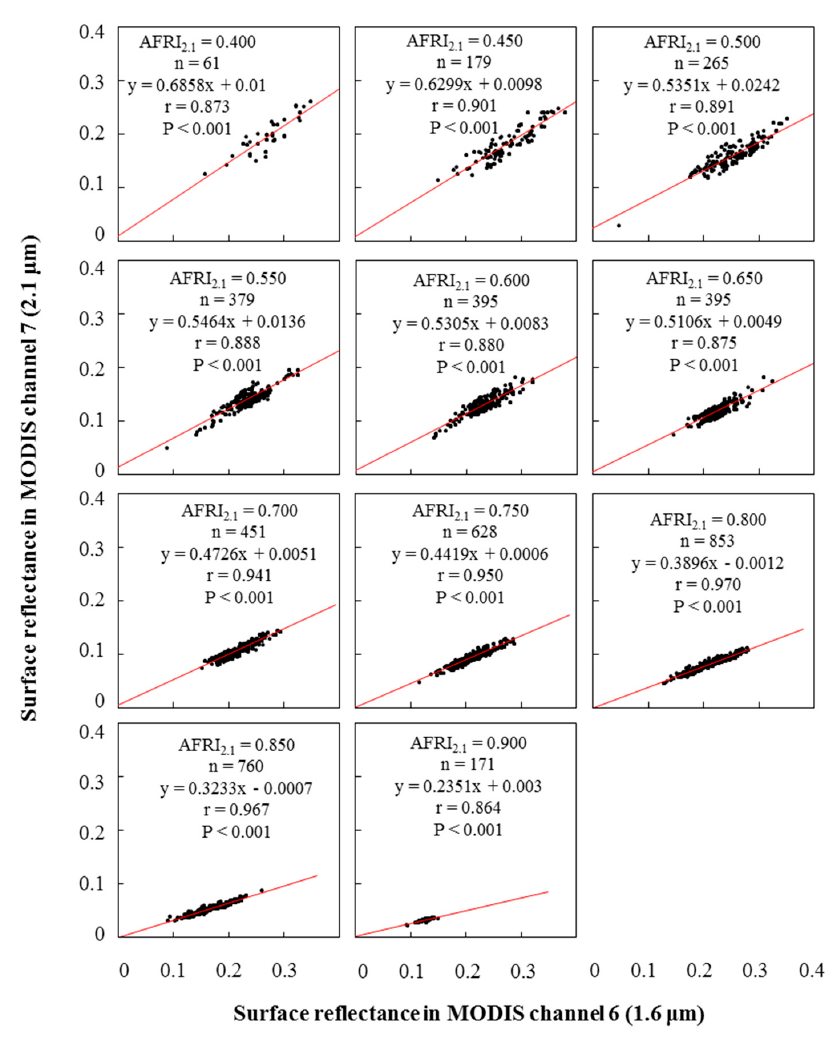
Figure 3. The relationship between surface reflectances at 2.1 µm and 1.6 µm vary with different Aerosol Free Vegetation Index (AFRI 2.1 ) values. (All data points in each graph fall within the AFRI 2.1 value ± 0.001).